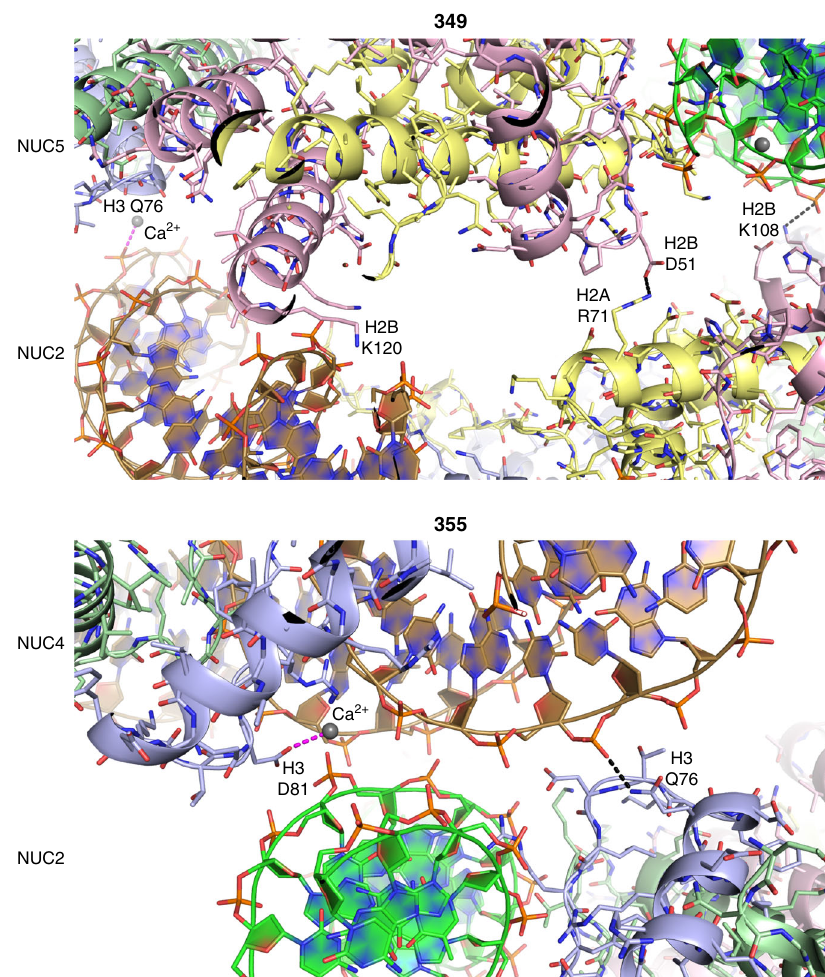
Fig. 3 Intra fi bre nucleosome-nucleosome interactions. Nucleosome-nucleosome interfaces within the 349 and 355 fi bres are shown with dashed lines indicating hydrogen bonds (black) and coordinate bonds (magenta; Ca 2 + ions, grey spheres). The cores histones are shown in pale yellow (H2A), pink (H2B), purple (H3) and green